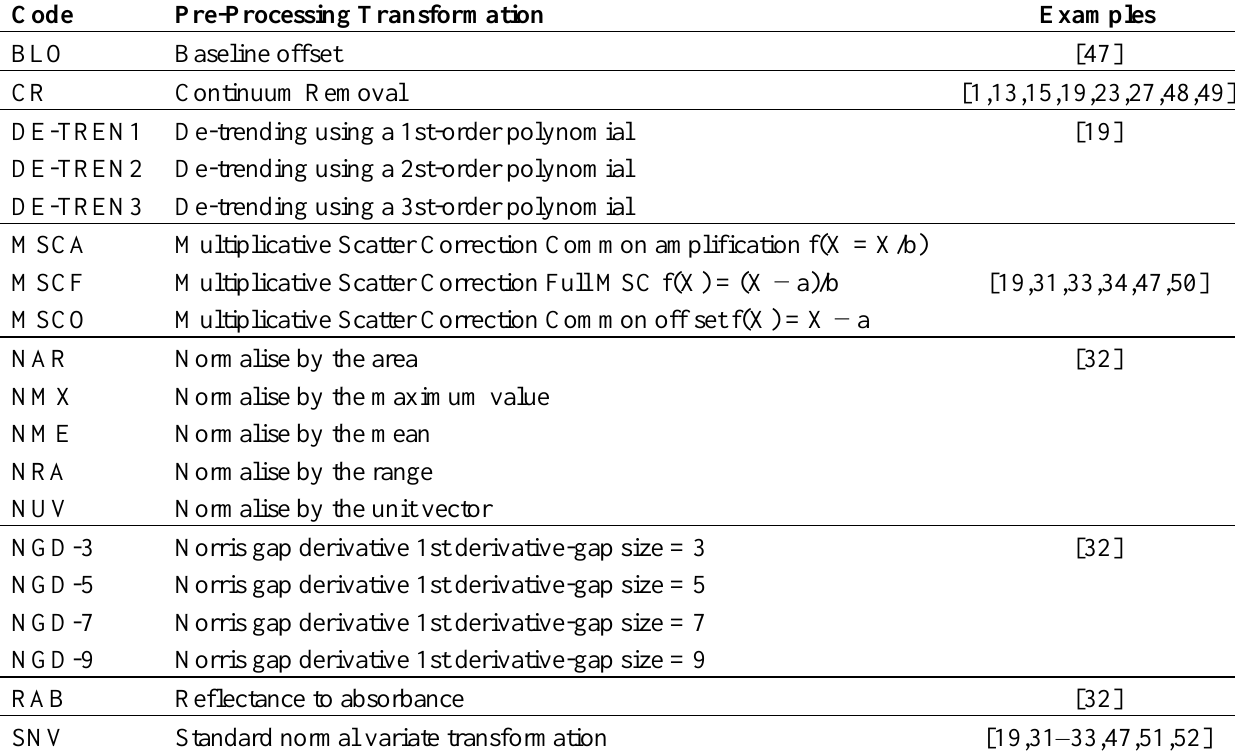
Table 4. Pre-processing transformations compared in this